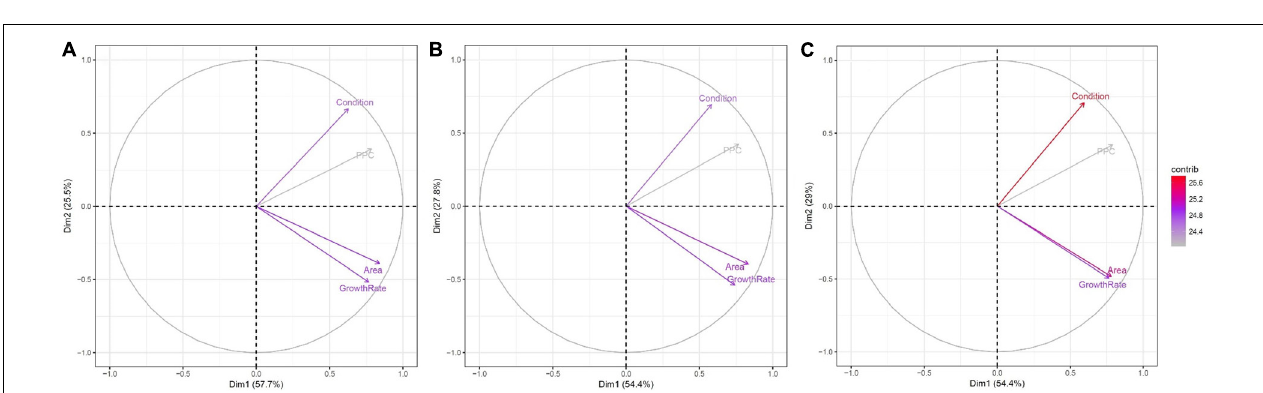
FIGURE 10 | Relationship of field-derived total yield mass per plant with (A) plant condition at harvest, (B) plant area at harvest, (C) maximum daily growth rate throughout growing season and (D) PPC of tomato plants at harvest, and the number of accessions eliminated from using each phenotypic traits to identify the best-performing accessions in terms of yield.